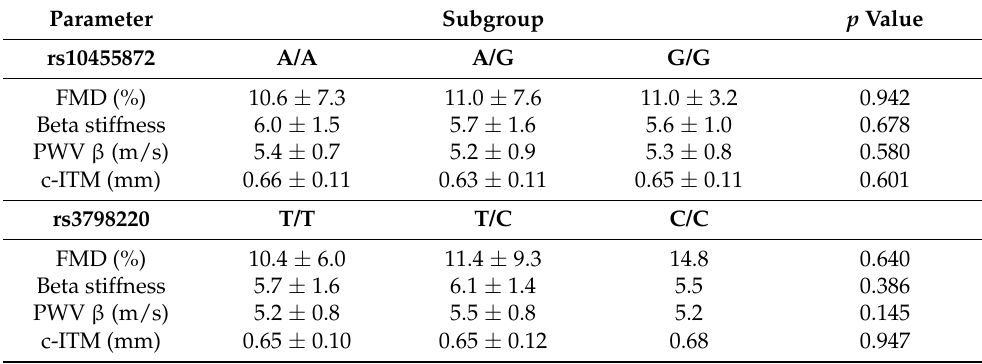
Table 5. Functional and morphological properties of the arterial wall for the different LPA genotype and haplotype sub- groups.